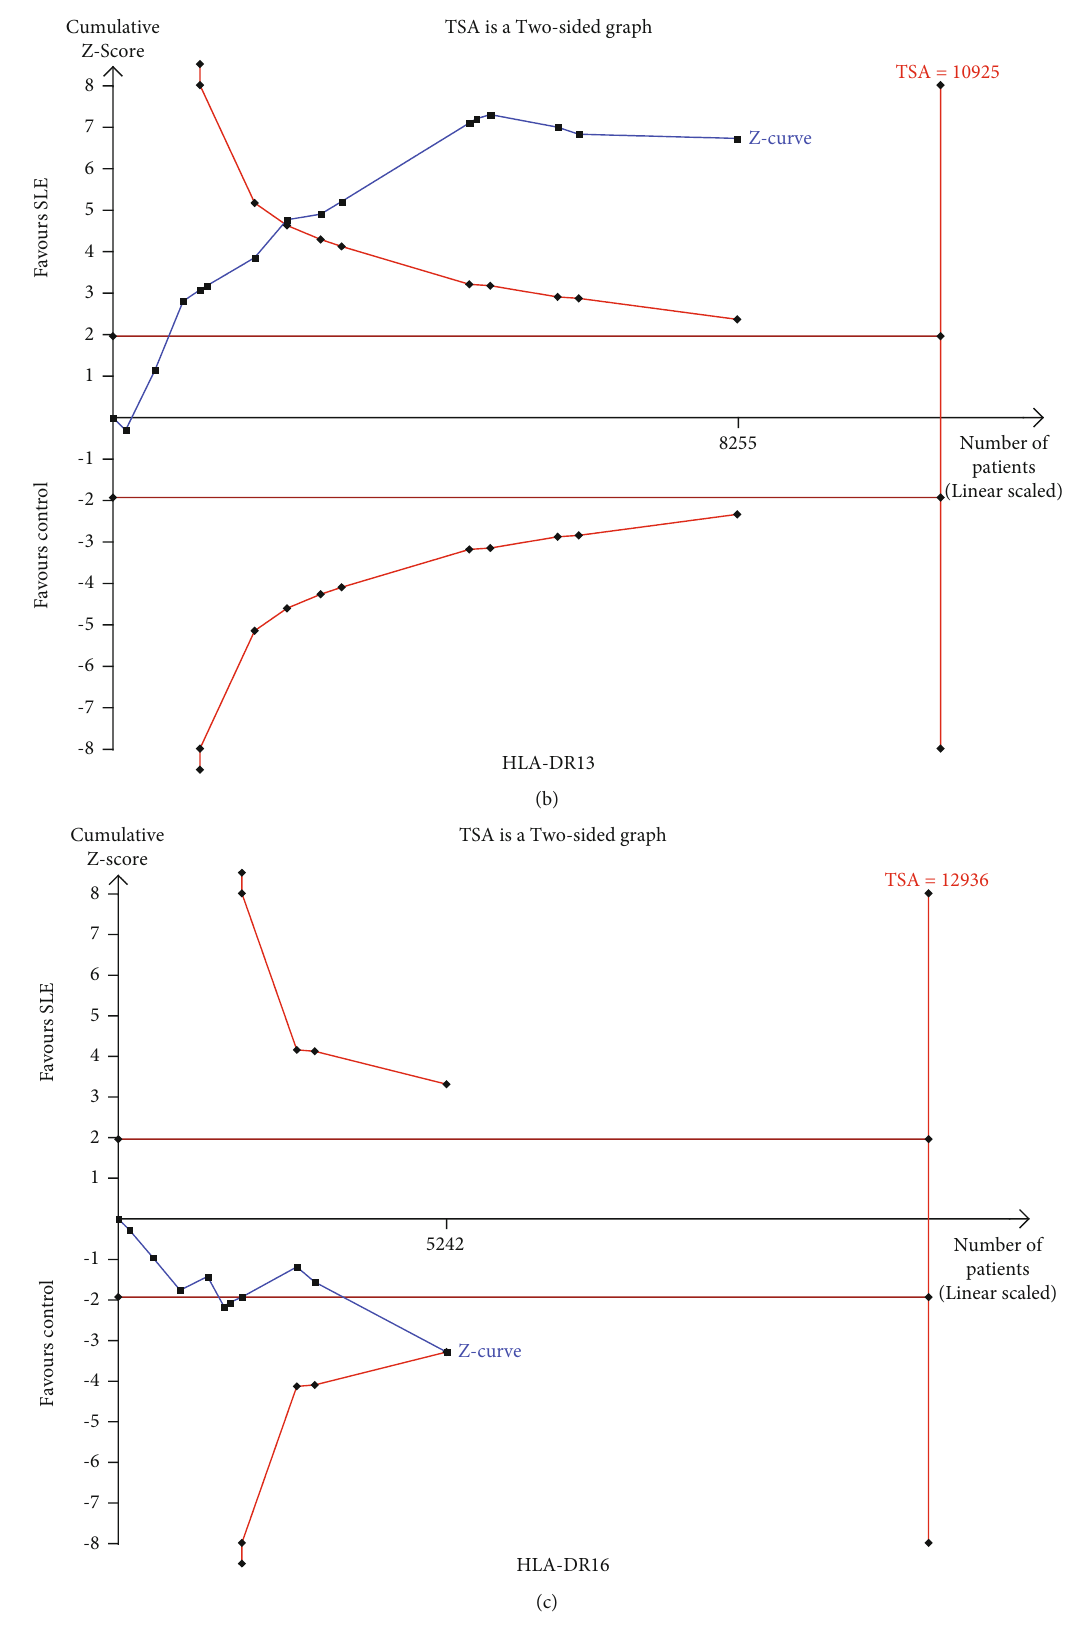
Figure 4: Trial sequential analysis of SLE risk associated with HLA-DR1 (a), HLA-DR13 (b), and HLA-DR16 (c)